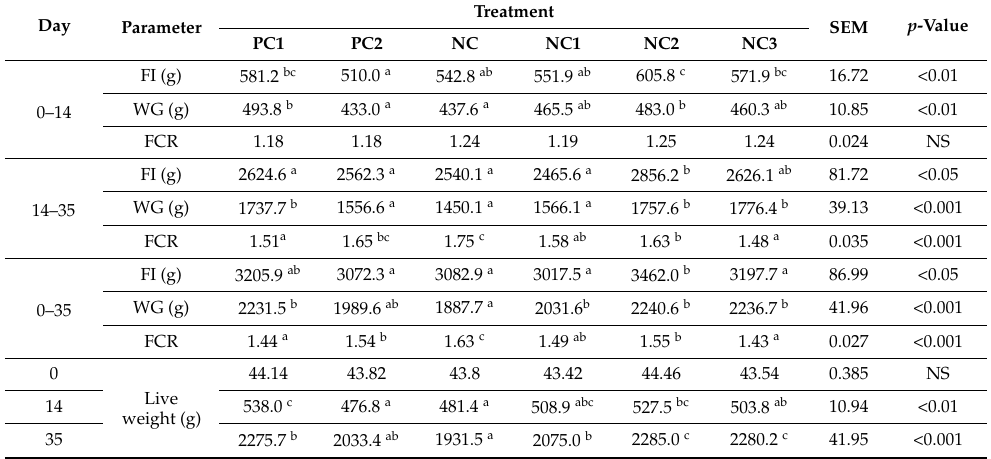
Table 4. The effect of the plant materials on feed intake (FI), weight gain (WG), and feed conversion ratio (FCR) from 0 to 35 days of